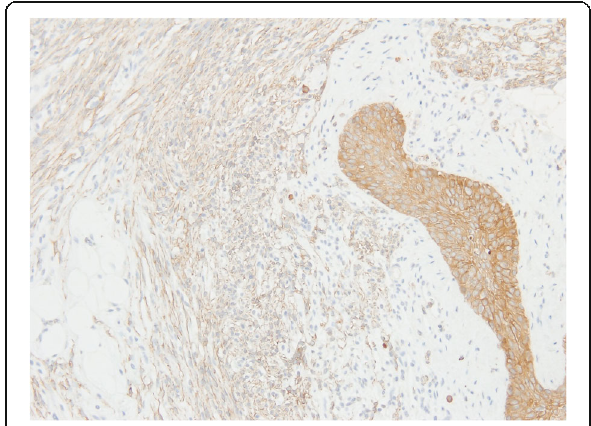
Fig. 4 In immunohistochemical examination, the epithelial nests were strongly positive for cytokeratin (CK) AE1/AE3, and the spindle- shaped cells were weakly positive for CK